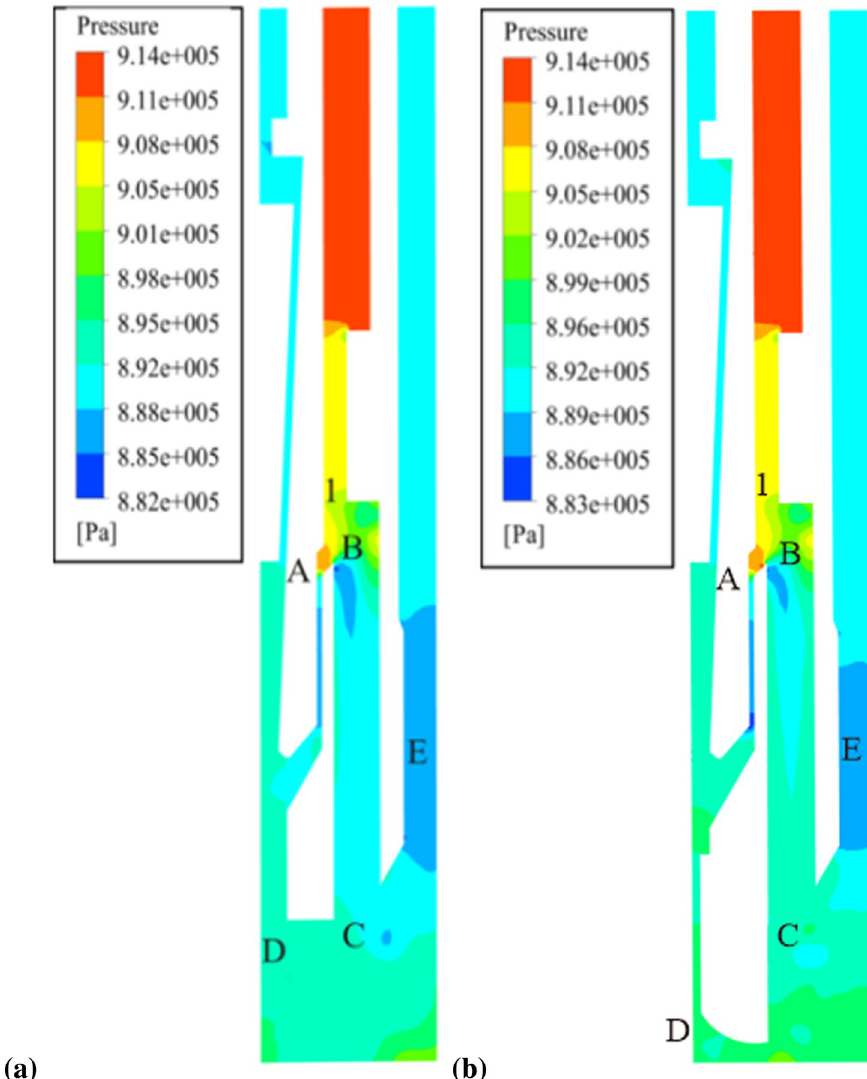
Fig. 8 Pressure contour cross-section of nozzles. a Main nozzles cross-section. b Assistant nozzles